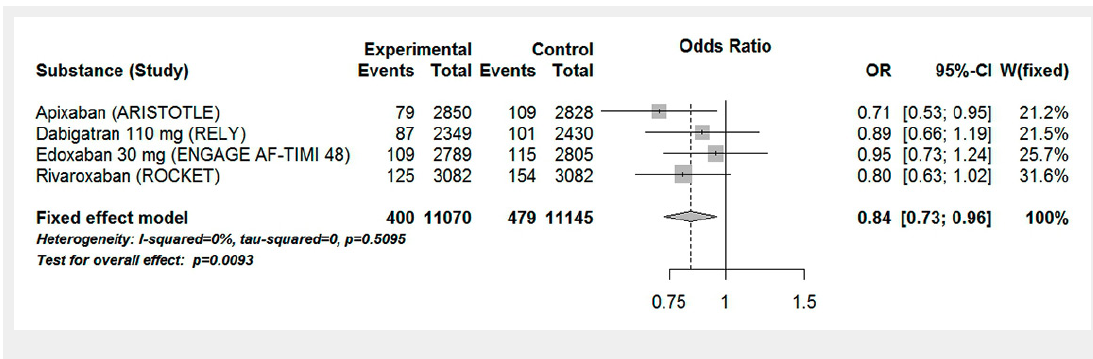
Figure 4 Forest plot of stroke or systemic embolism in patients with atrial fibrillation aged 75 years or over for analysis including low-dose dabigatran and edoxaban. CI = confidence interval; experimental = direct oral anticoagulants; control = vitamin K antagonists